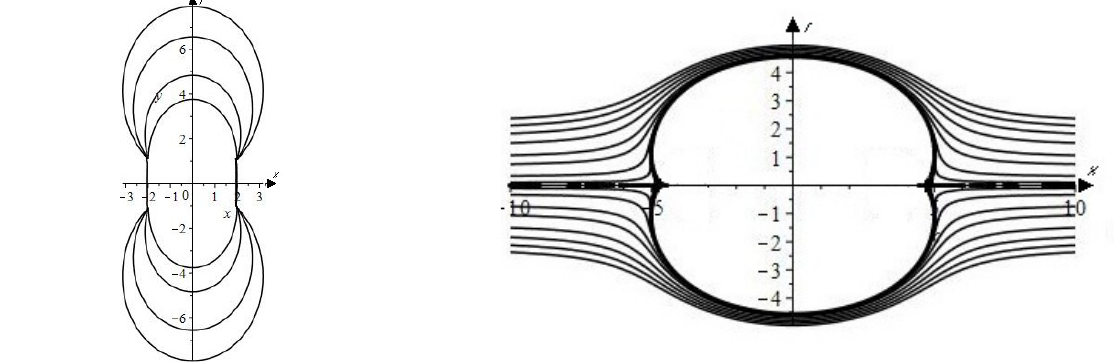
Figure 1: A system of pseudosources and pseudosinks. Figure 2: The streamline along an “oval" solid of rotation with cavities.